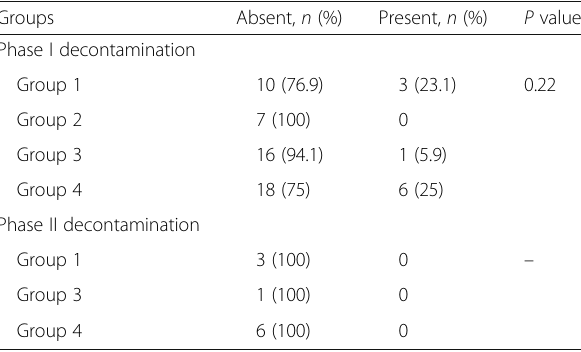
Table 4 Association of microbial occurrence in different groups with phase I and II